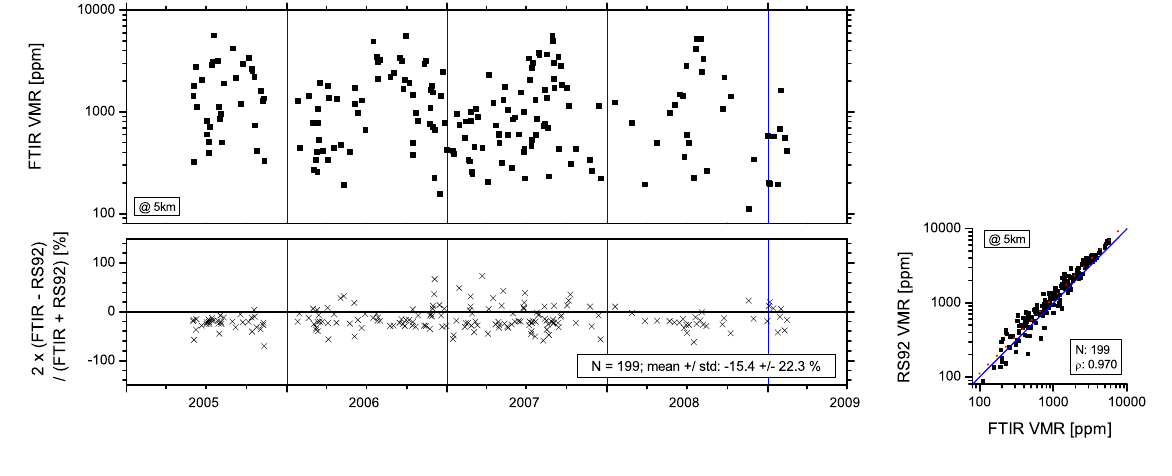
Fig. 10. Same as Fig. 9 but for the middle troposphere (altitude of 5km). the FTIR overestimates the RS92 values by 21 . 8%. The scat- ter between FTIR and RS92 is 28 .